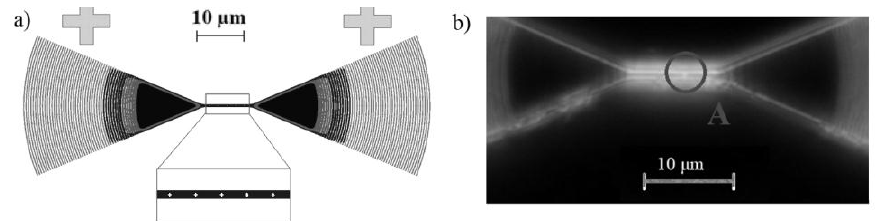
Fig. 1. Structures of Si 3 N 4 for the integration of nanodiamonds. (a) Schematics of the nanophotonic device with two diffraction grating couplers, waveguide, golden markers and holes for nanodiamonds. (b) Microphotograph of nanophotonic structure in a dark field. Structure after application of nanodiamonds and erasing of the resist. Letter “A” is put near some nanodiamond-like